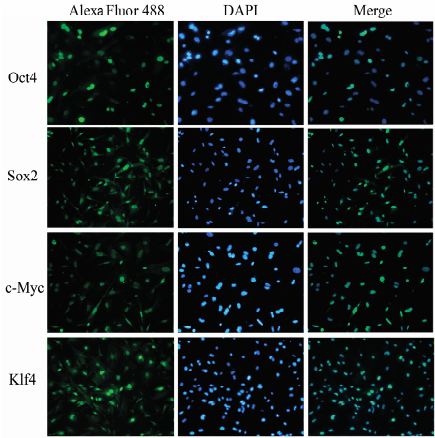
Figure 4. Transfection of MEF with mRNA of the four transcription factors. Cells were transfected with 1 µg mRNA (0.25 µg of each factor) and immunostained for the expressed proteins of the introduced factors after 24 h, showing nuclear localization of the 4 factors. Cellular nuclei were counter-stained by 4',6-diamidino-2-phenylindole (DAPI); (magnification